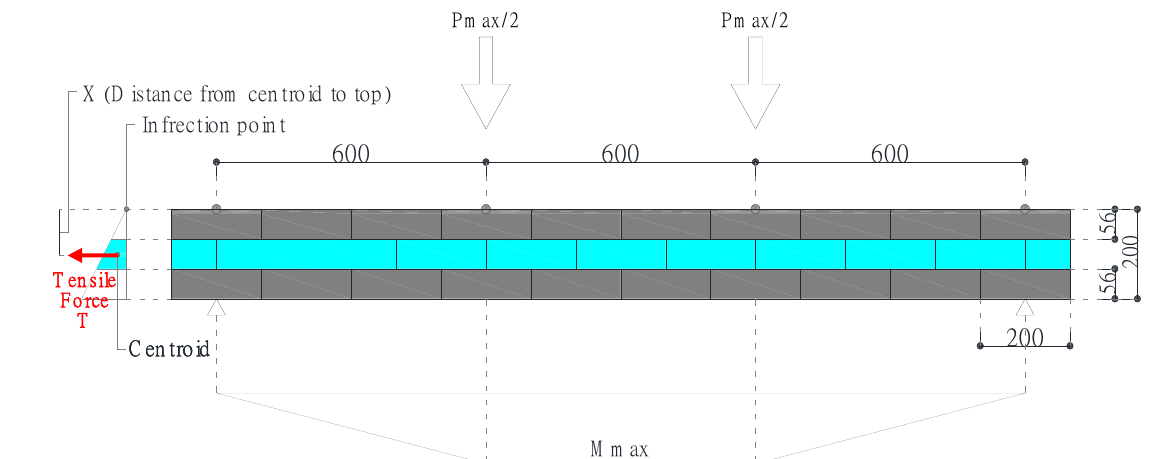
Figure 18. Overview of laying work.